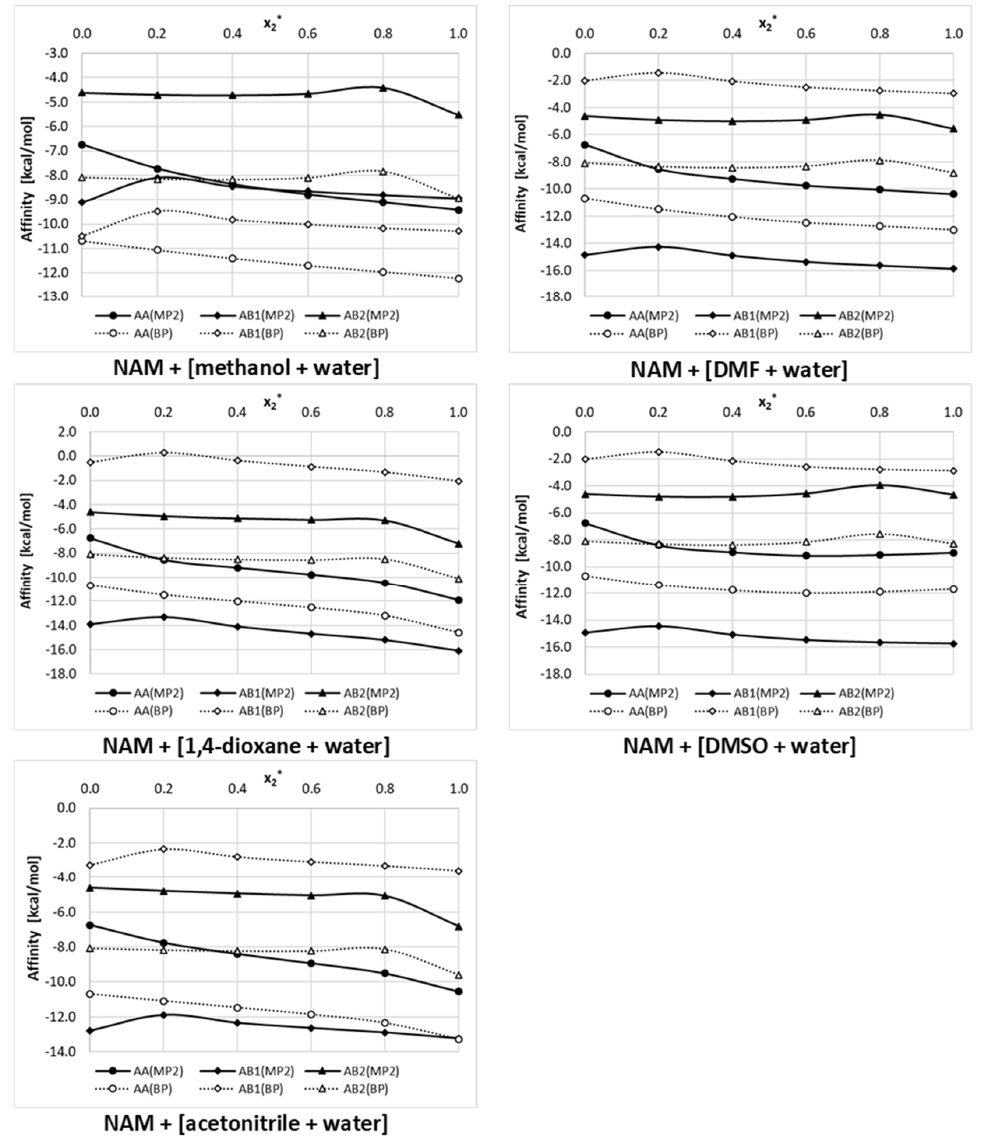
Figure 7. Concentration dependent nicotinamide affinity in aqueous binary solution of studied organic solvents (x 2 * denotes mole fraction of organic solvent in solute free